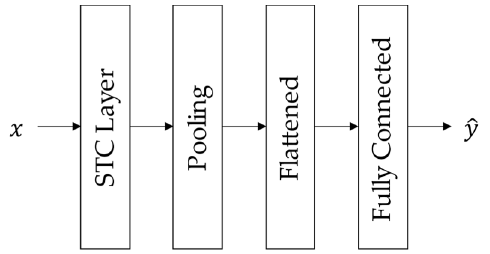
Figure 2. Basic TGCN architecture for the time-series prediction task.